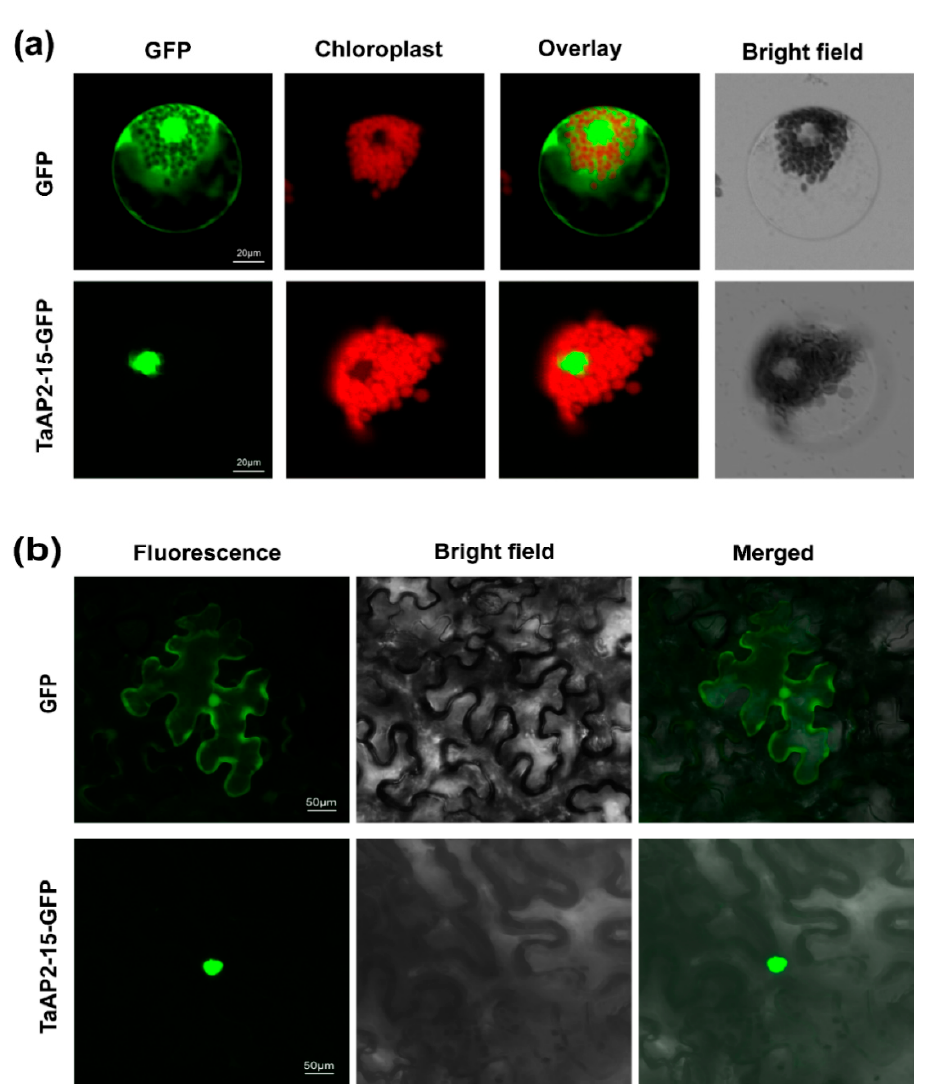
Figure 3. TaAP2-15 encodes a nuclear targeted protein. ( a ) TaAP2-15-GFP fused proteins were overexpressed in wheat protoplasts through PEG-mediated transfection method. GFP was used as a control. ( b ) TaAP2-15-GFP fused proteins were overexpressed in tobacco through agrobacterium-mediated transformation. The constructs, GFP or TaAP2-15-GFP, were first introduced into A. tumefaciens then agroinfiltrated into N. benthamiana leaves. GFP signals were observed with an Olympus FV1000 confocal microscope with 488 nm